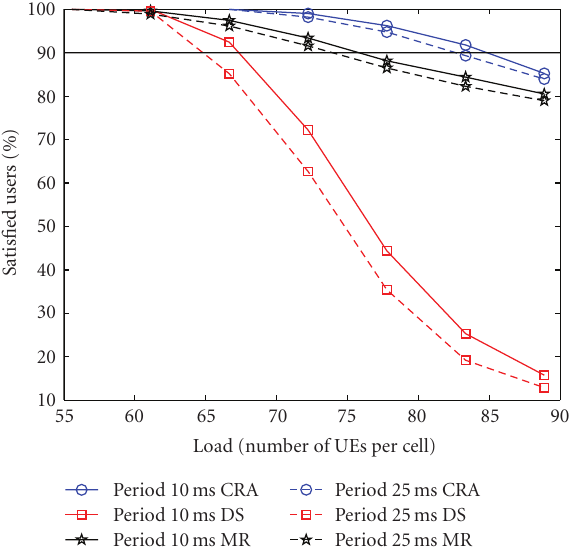
Figure 5: User satisfaction ratio in the Web-only scenario with variable channel state reporting periods for CRA, DS and MR